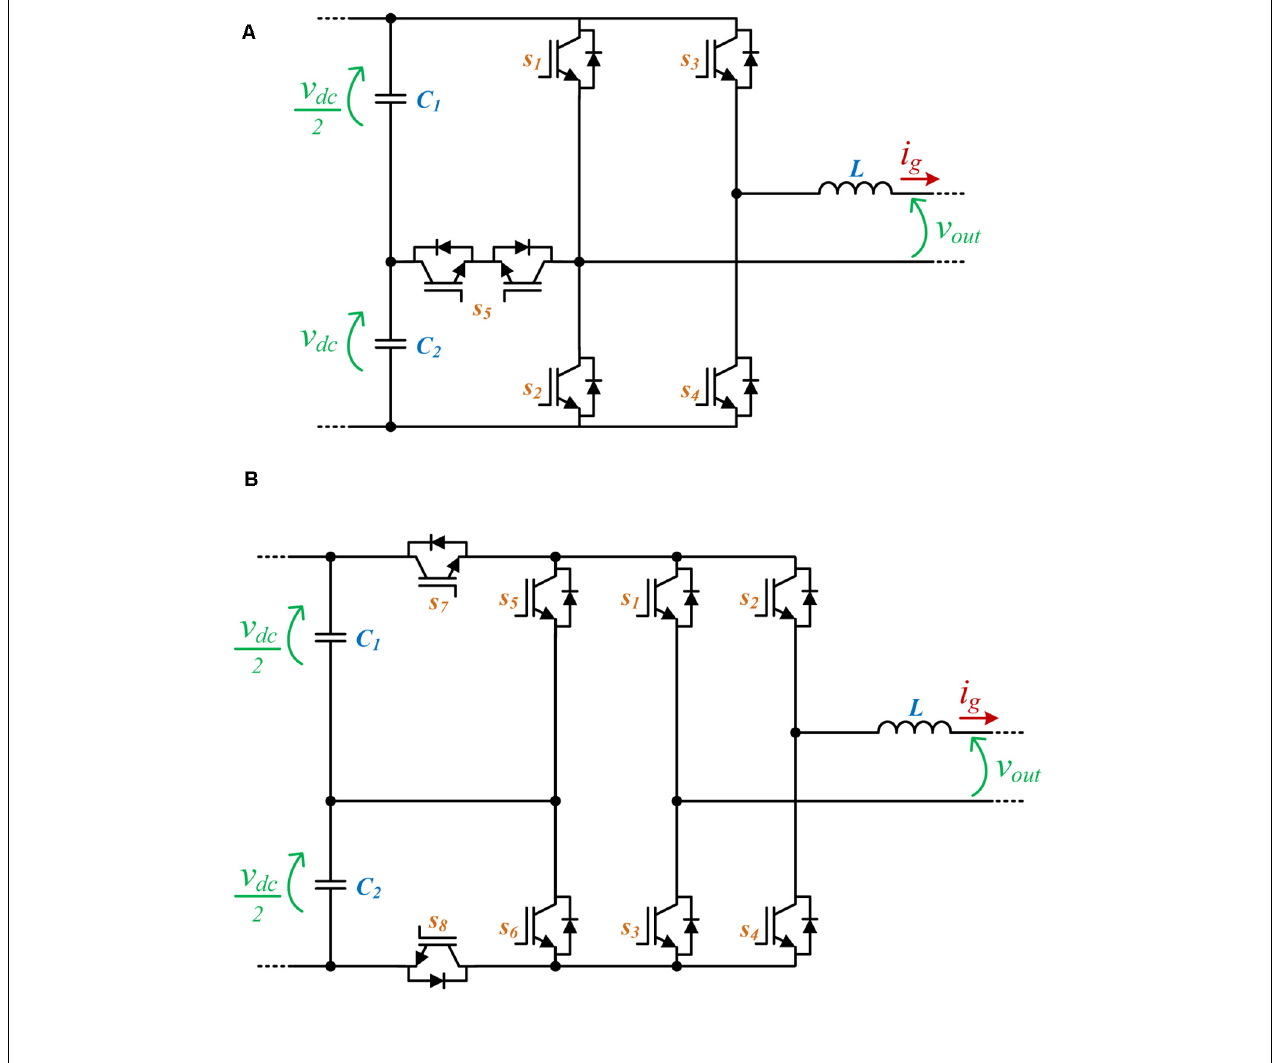
FIGURE 10 | Topologies: (A) proposed in Monteiro et al. (2016); (B) proposed in Leite et al.